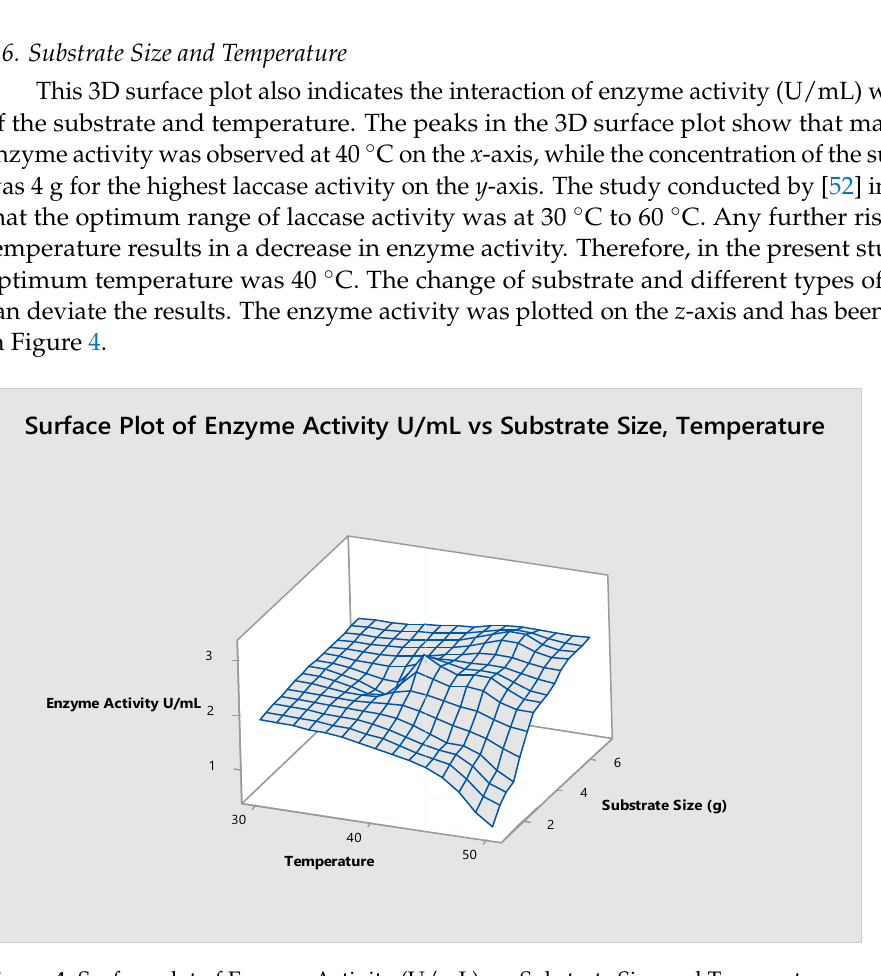
Figure 3. Surface plot of Enzyme Activity (U/mL) vs. Substrate Size and pH.